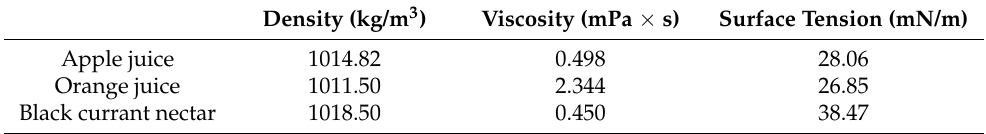
Table 3. Density, viscosity, and surface tension of apple juice, orange juice, and currant nectar at 70 ◦